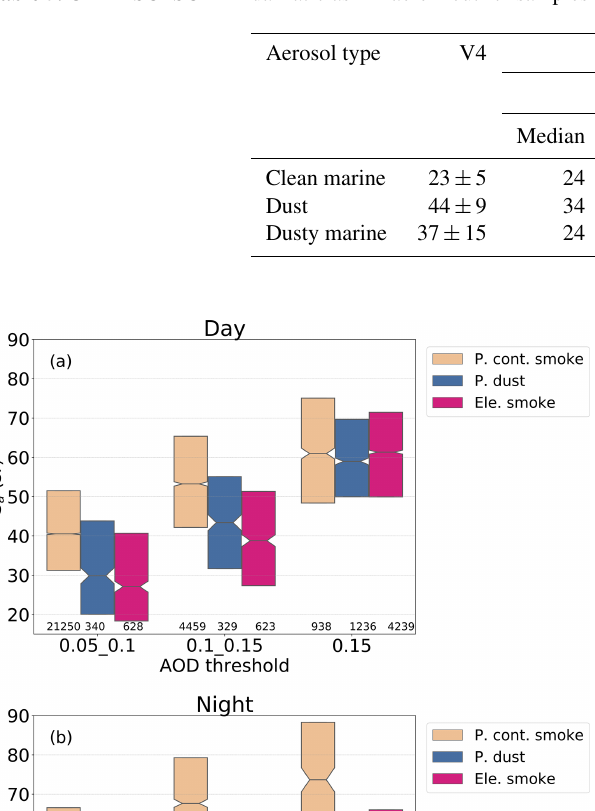
Table 5. CALIPSO–SODA lidar ratio as in Table 4 but for samples classified by CALIPSO at 5km spatial resolution.